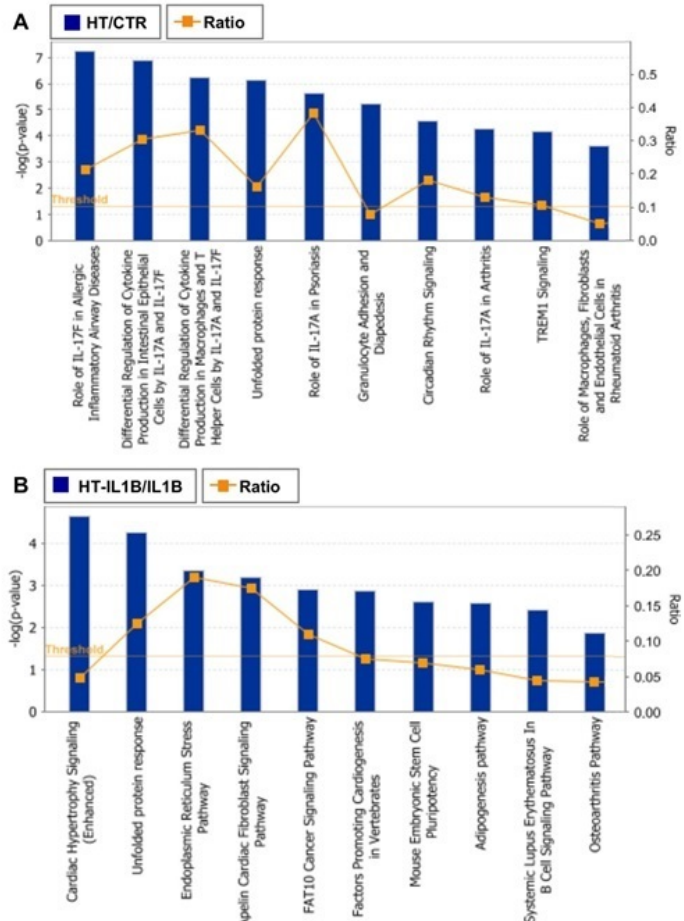
Figure 4. Top canonical pathways significantly modulated by HT at basal ( A ) and inflamed ( B ) conditions. Fisher’s exact test was used to calculate a p -value (shown as bars), determining the probability that the association between the genes in the data set and the canonical pathway is explained by chance. The ratio represents the number of differentially expressed genes in a given pathway divided by the total number of genes making up that canonical pathway.